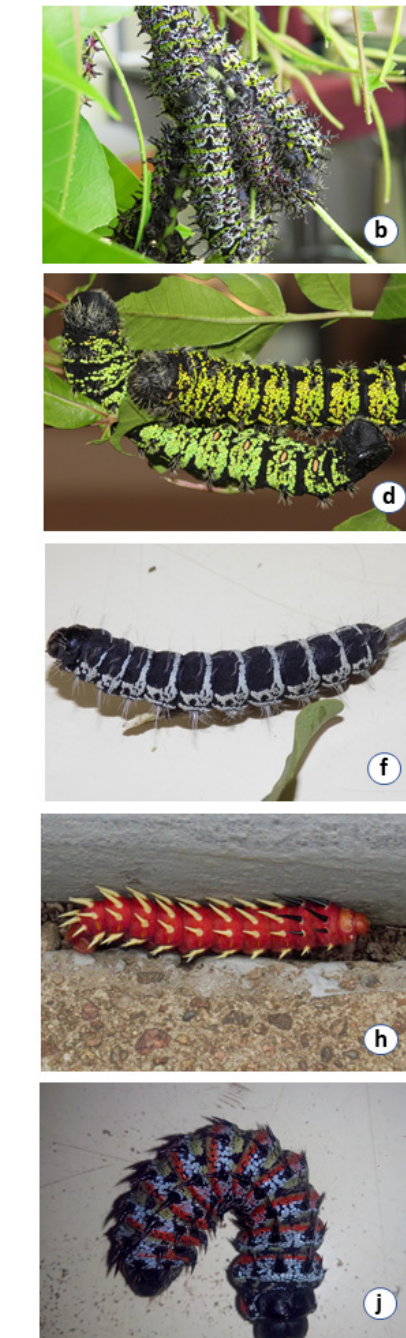
have white/yellow spines (Figure 2). Bunaea alcinoe moths are dark brown in color with a large glass spot on the forewing (Table 1). The hind wing has an orange eyespot ringed with black followed by white (Figure 3).